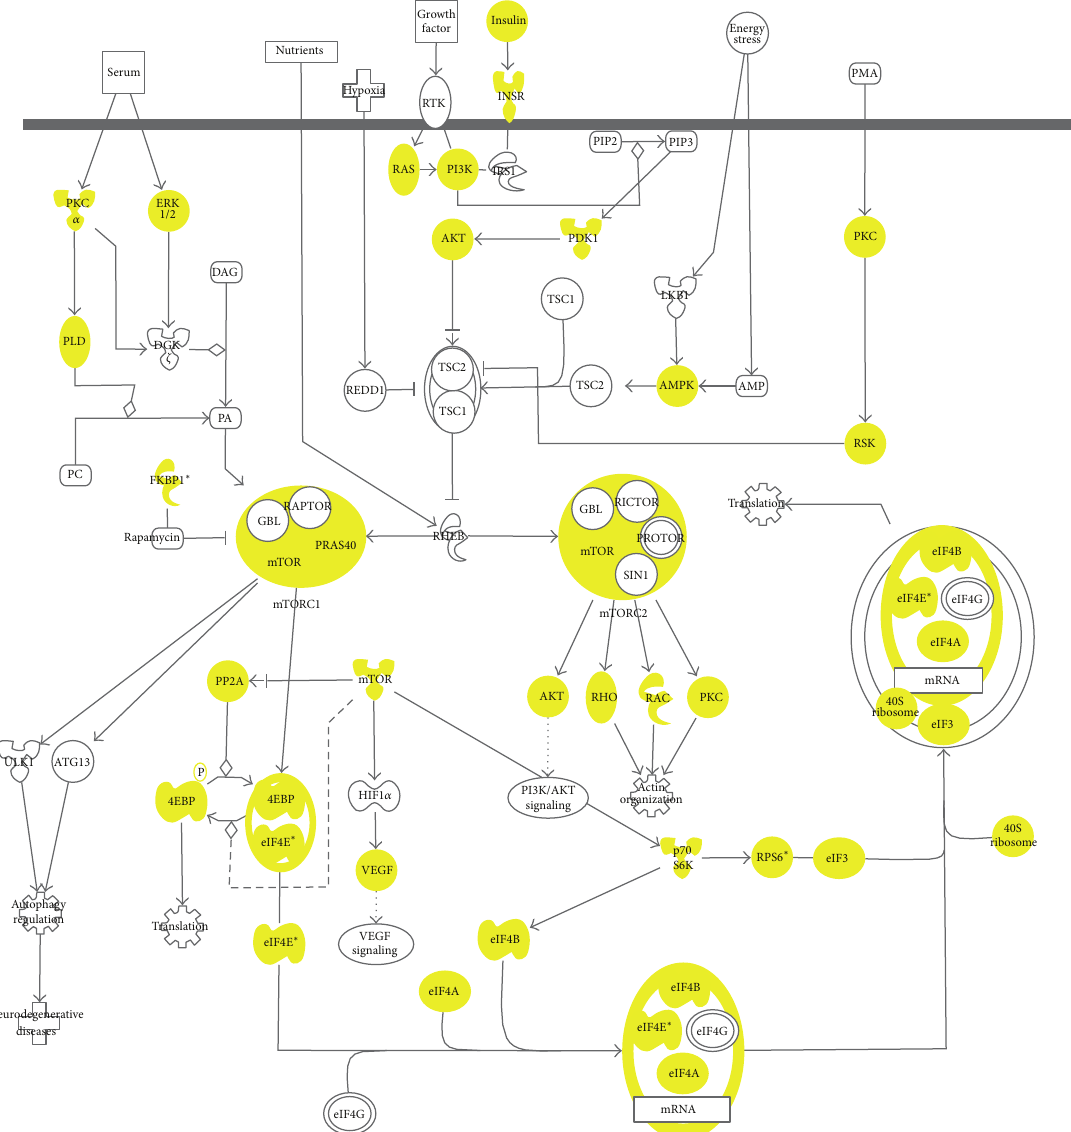
Figure 6: The PI3K/AKT/mTOR pathway as adapted from Ingenuity Pathway Analysis (IPA) database. The highlighted proteins in yellow depict our identified proteins from our 2D-LC-MS/MS analysis. A total of 79 proteins from our identified dataset from our 2D-LC-MS/MS are associated with this